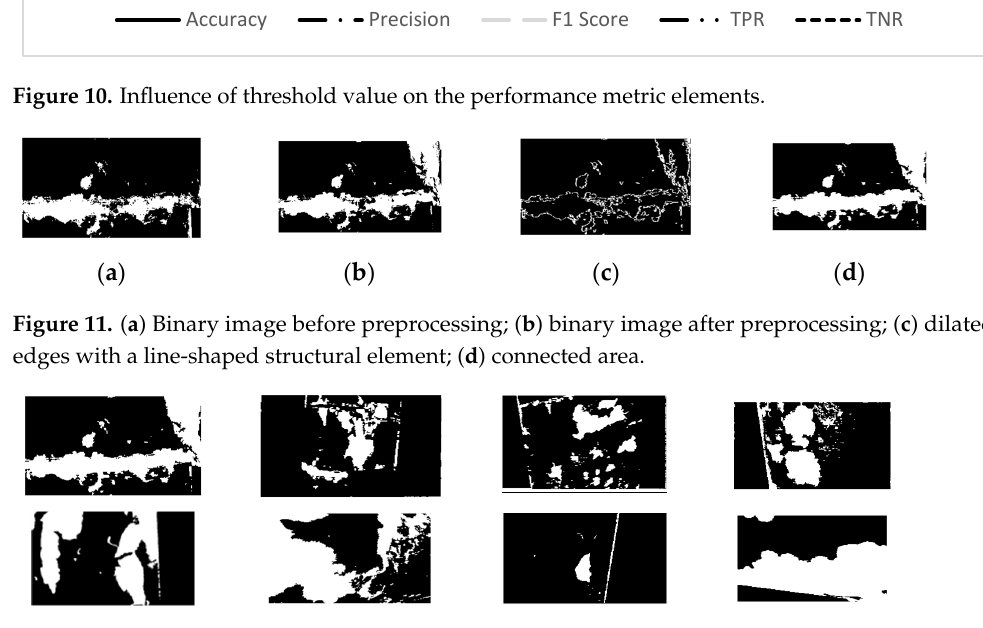
Figure 12. Separation of corroded parts through the proposed method .